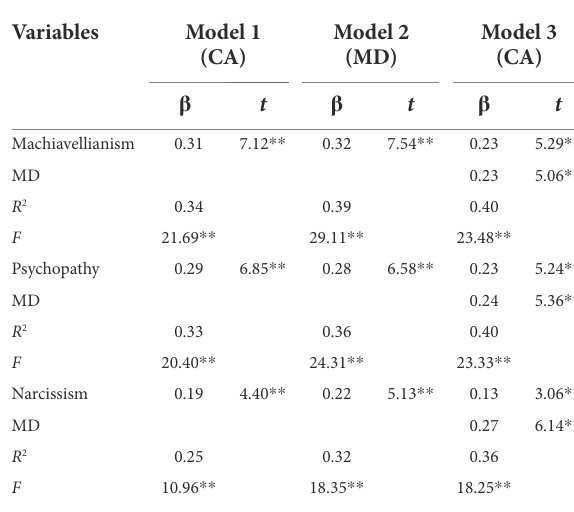
TABLE 3 Testing the mediation effect of moral disengagement ( N =